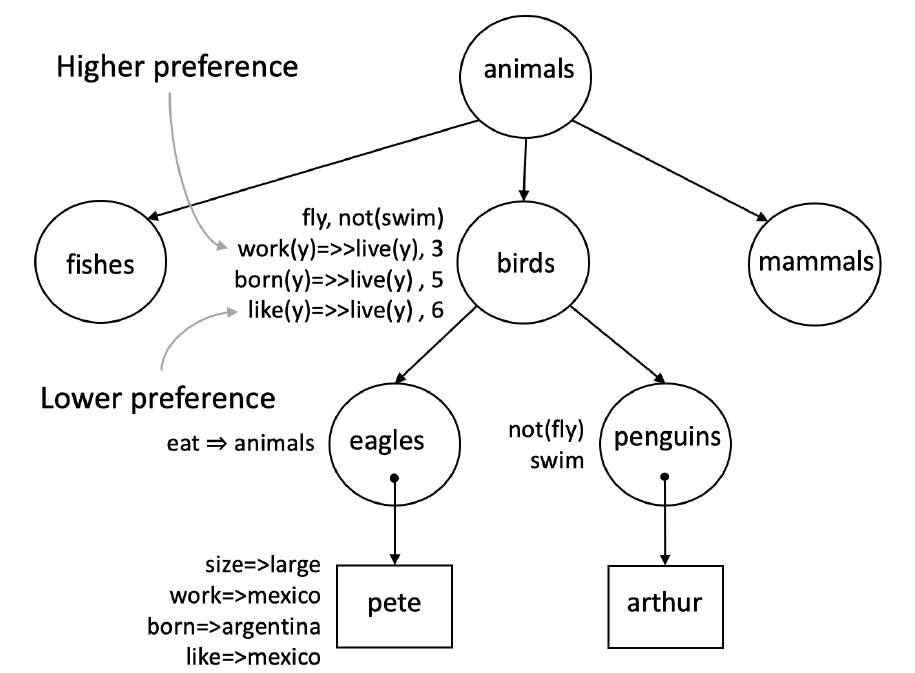
Figure 5. Non-monotonic